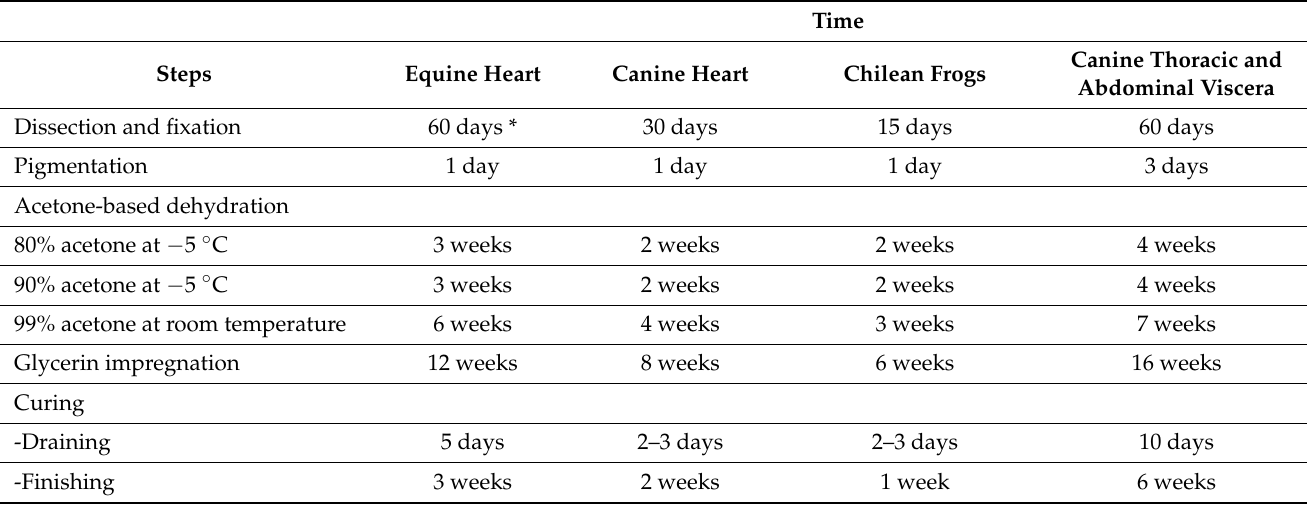
Table 1. Steps and duration of Elnady Technique process required to prepare 4 biological